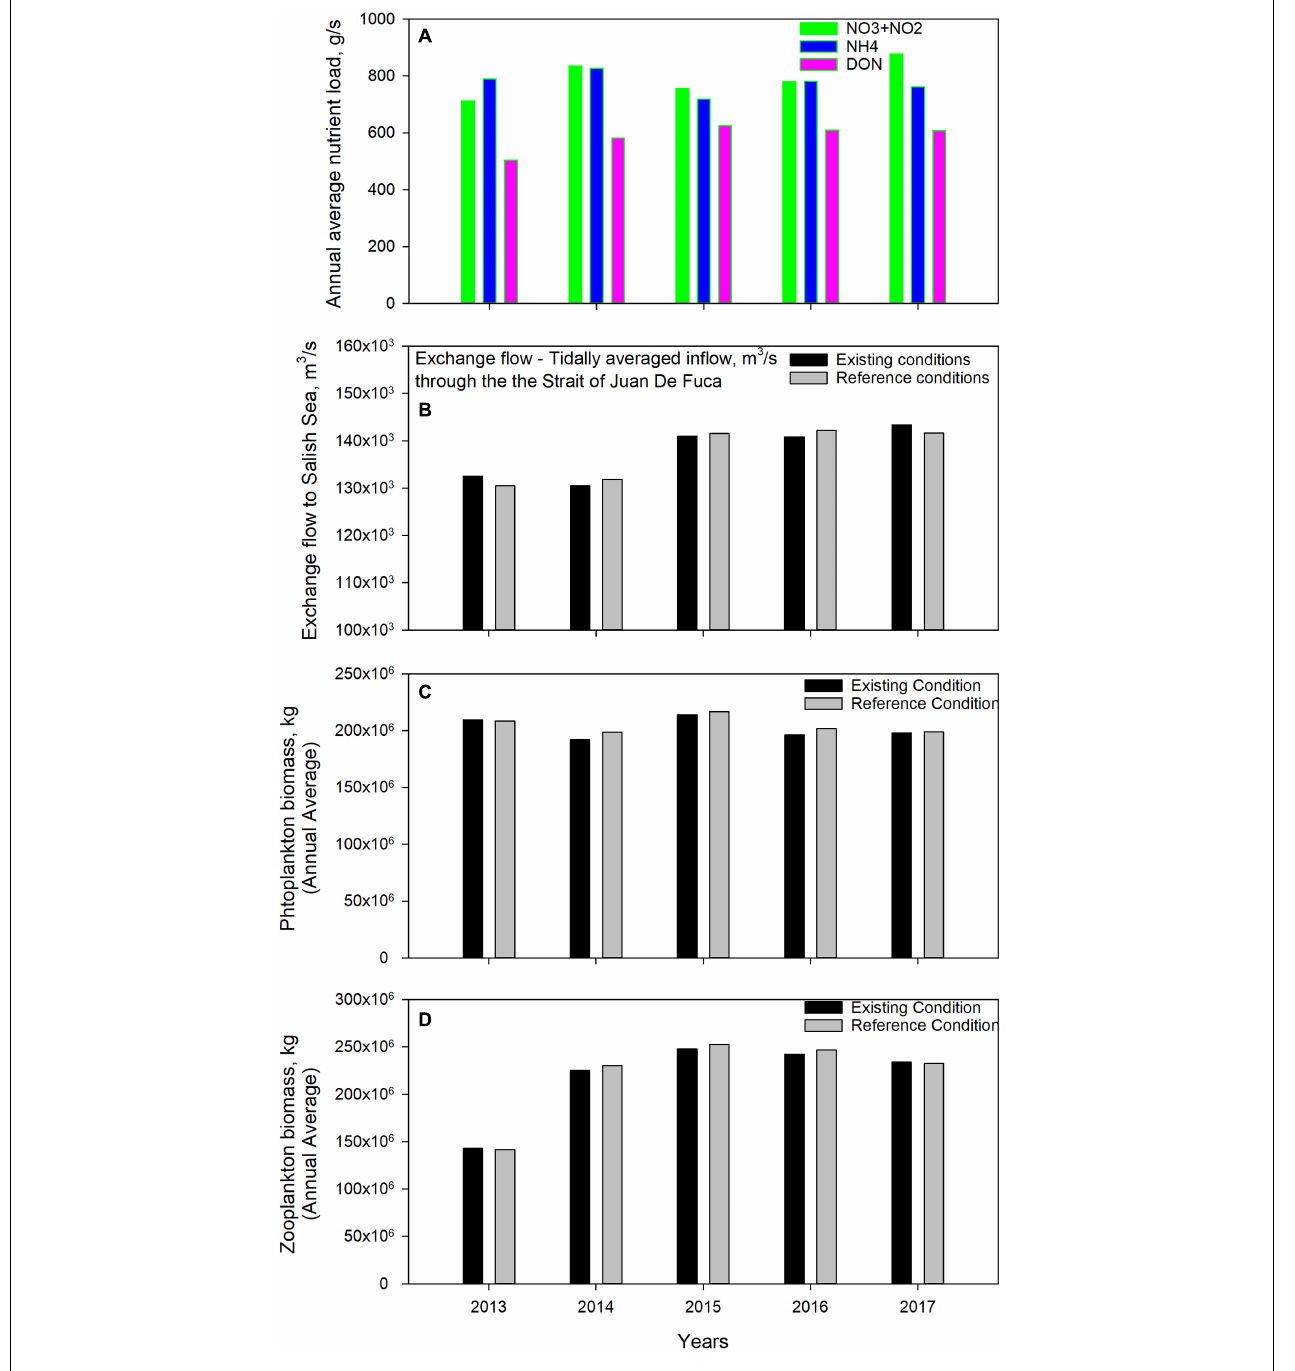
FIGURE 12 | Comparison of modeled annual average (A) nutrient loads (estimated using observed flow based regressions), (B) magnitudes of estuarine exchange flow, (C) phytoplankton biomass, and (D) zooplankton biomass. For (B–D) , existing conditions simulation with the marine heatwave are compared to the reference condition simulations without the anomalous